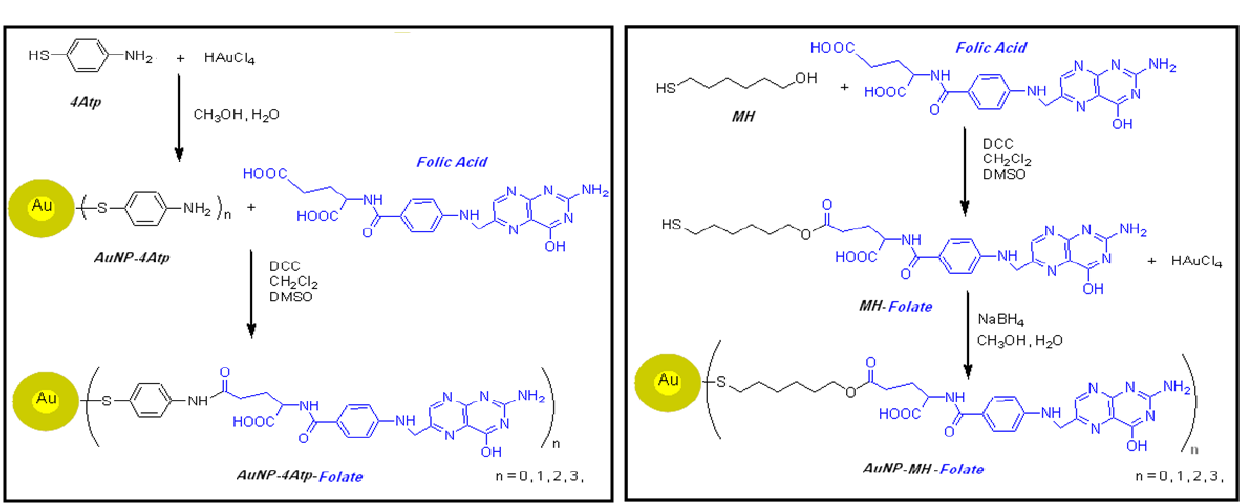
Figure 4. Schemes for the synthetic procedures of folate conjugated with AuNP using 4Atp (left scheme) [25-27] and MH (right scheme) [28,29] as the linkers to produce